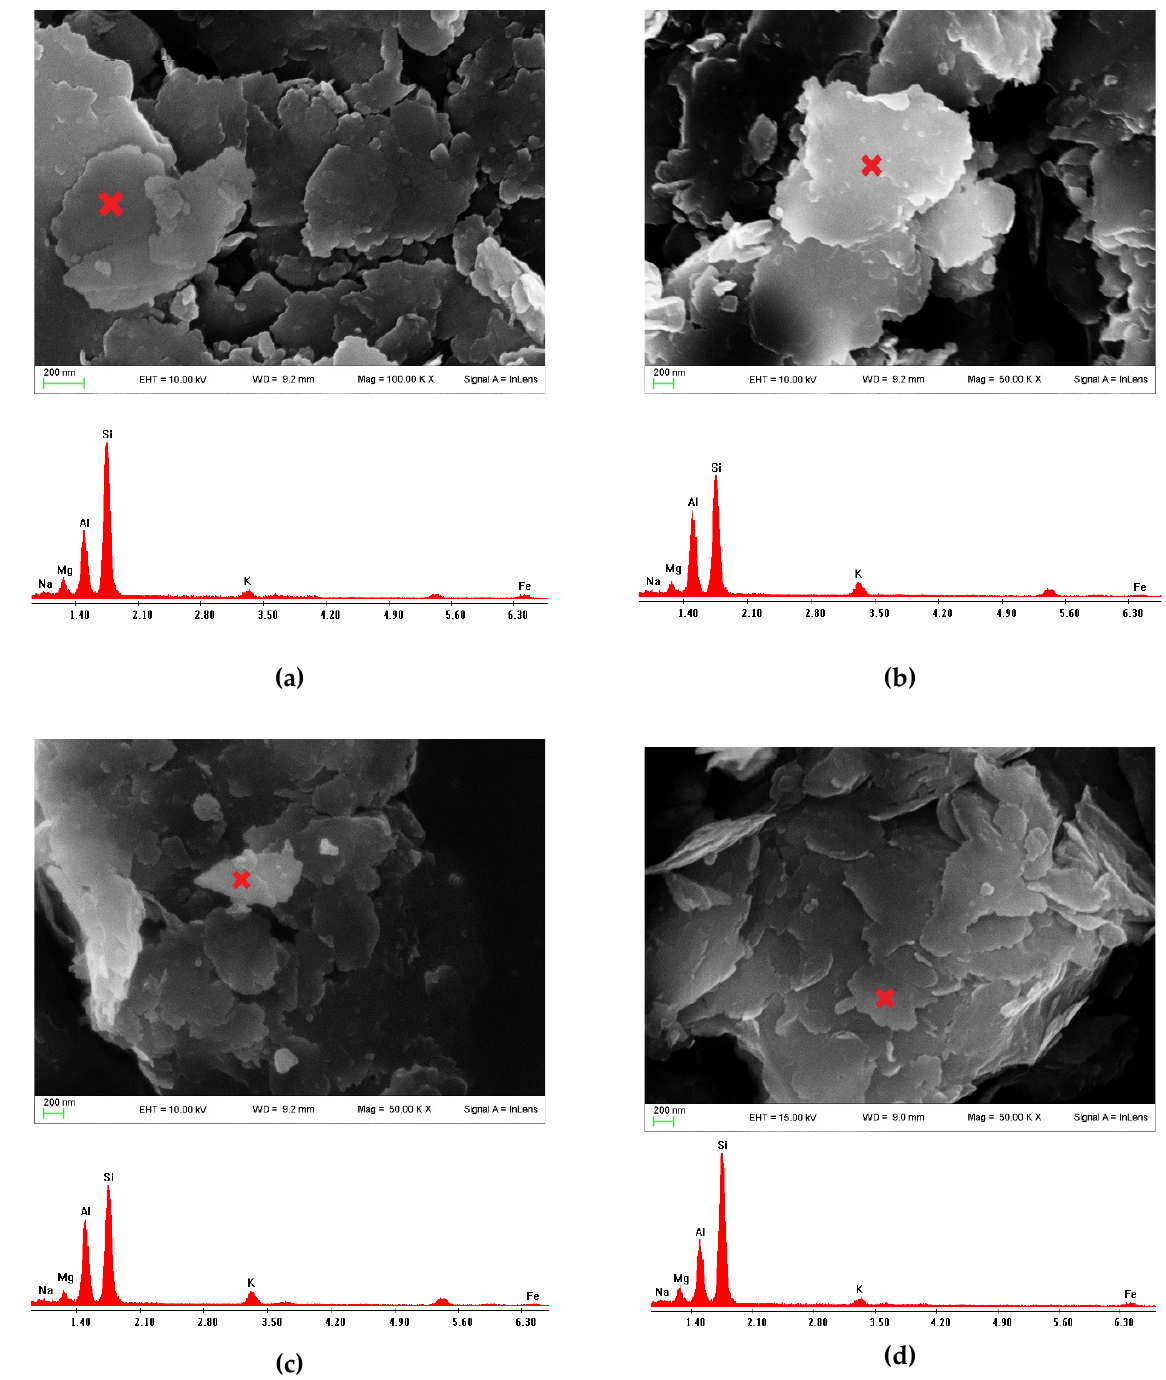
Figure 7. Fe-SEM photos of PR ( a ), PR/PeA at 0 days of curing ( b ), PR/OlA at 0 days of curing ( c ), and PR/GRA at 0 days of curing ( d ). For each photo, the chemical analysis (EDS) is reported below. Red crosses indicate the points at which analyses were carried out. The images show the typical lamellar structures of clay minerals.